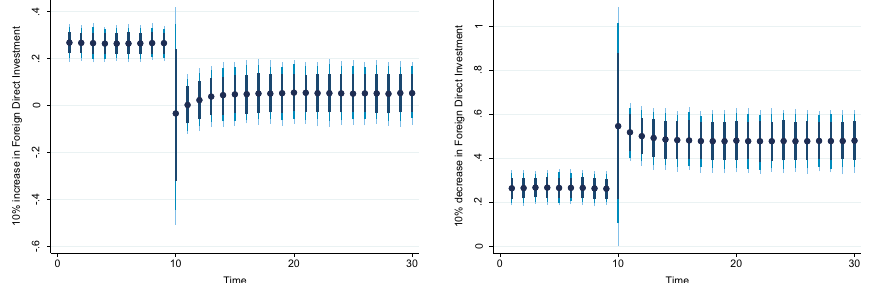
Fig. 6 The impulse response plot for foreign direct investment inflows and CO 2 emissions. This figure shows a 10% increase and a decrease in foreign direct investment and its influence on CO 2 emissions where dots specify average prediction value. However, the dark blue to light blue line denotes 75, 90, and 95% confidence interval,